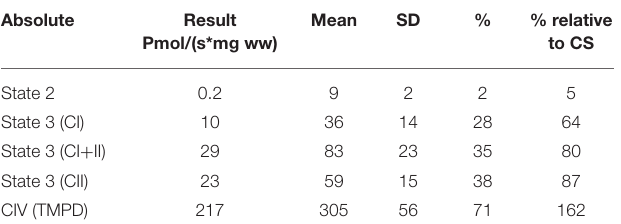
TABLE 2 | Mitochondrial high resolution respirometry from muscle.